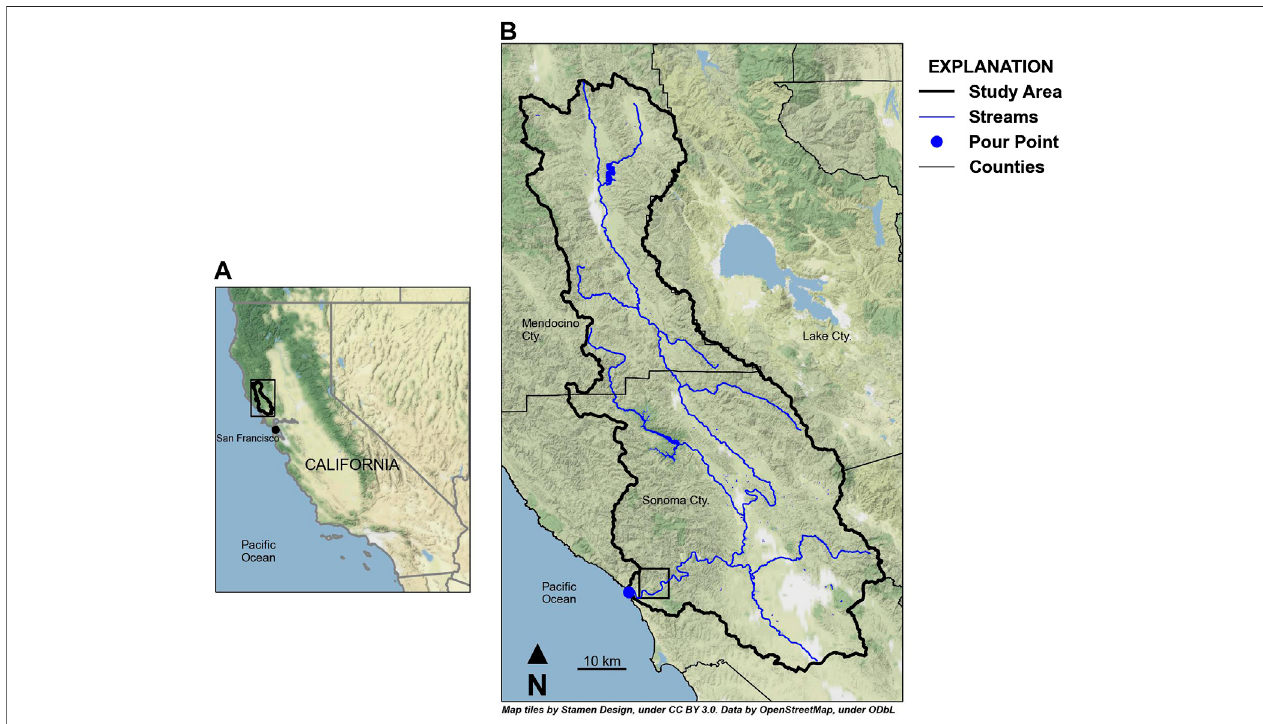
FIGURE 1 | Location of the Russian River watershed study area in northwestern California (A) . Main drainages of the Russian River watershed provided by NHDPlusdataset(ButoandAnderson,2020)withinthestudyareaboundary (B) .Blackboxinsetin (B) de fi nestheboundaryfor fl owdirectionvectorsshownin Figure3 .